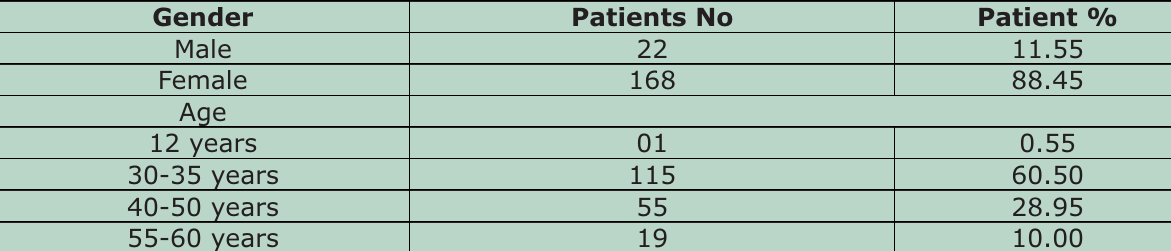
Table-I: Patients demographics (n=190).